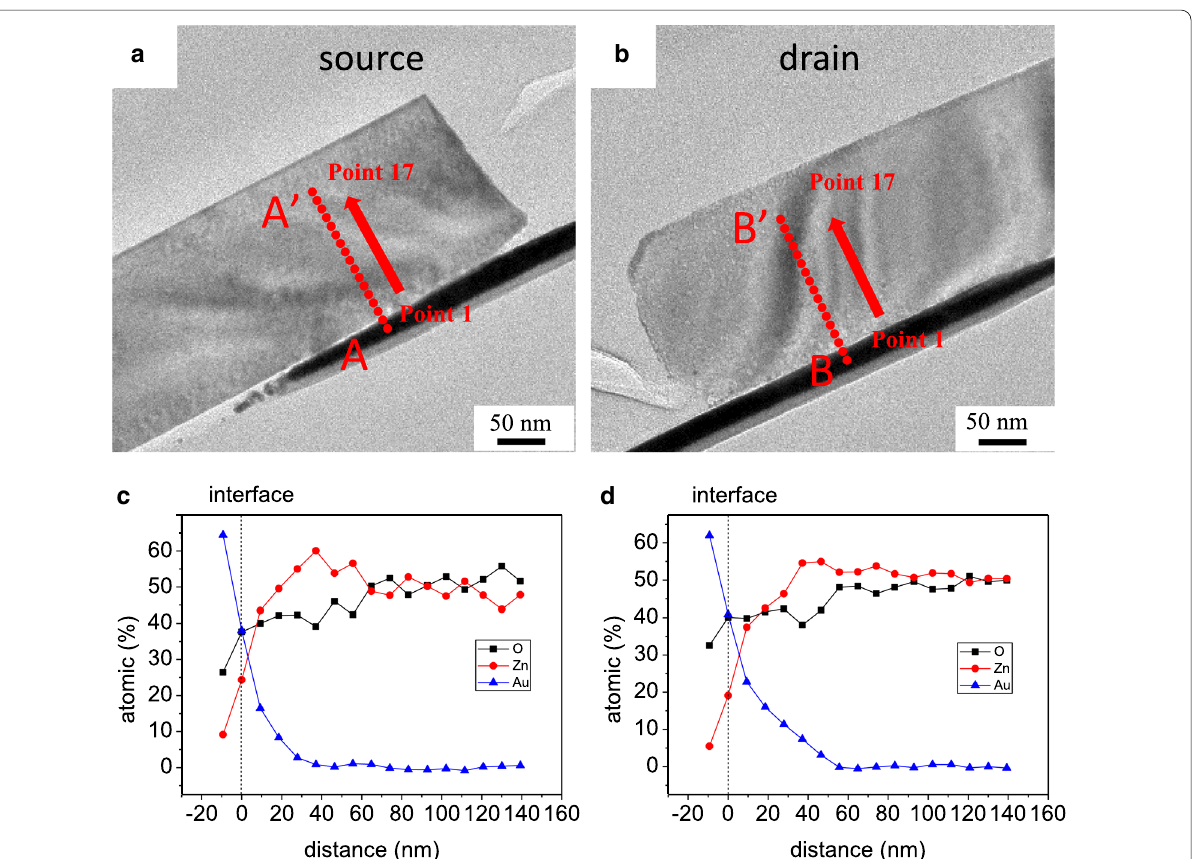
Fig. 6 Chemical composition of the ZnO/Au interfaces at both sides of the ZnO NW was determined by energy‑dispersive X‑ray spectroscopy (EDS). The TEM images of the a drain and b source sides of ZnO NW. c The concentration distance profiles of Zn, O and Au along the c AA ′ and d BB ′ are shown in a , b ,